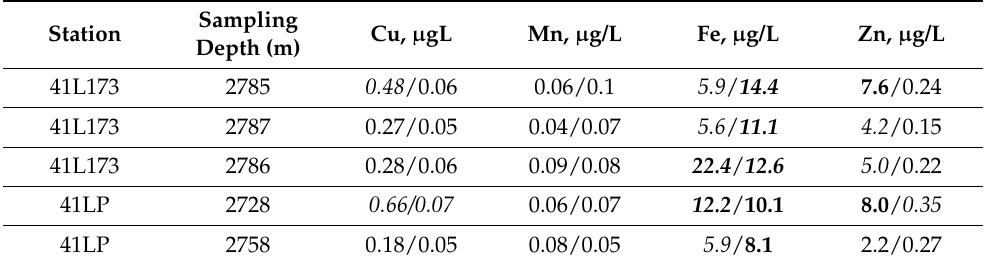
Table 4. Elevated (in italics), high (in bold), and abnormal (in italics and bold) concentrations of dissolved/solid microelements.